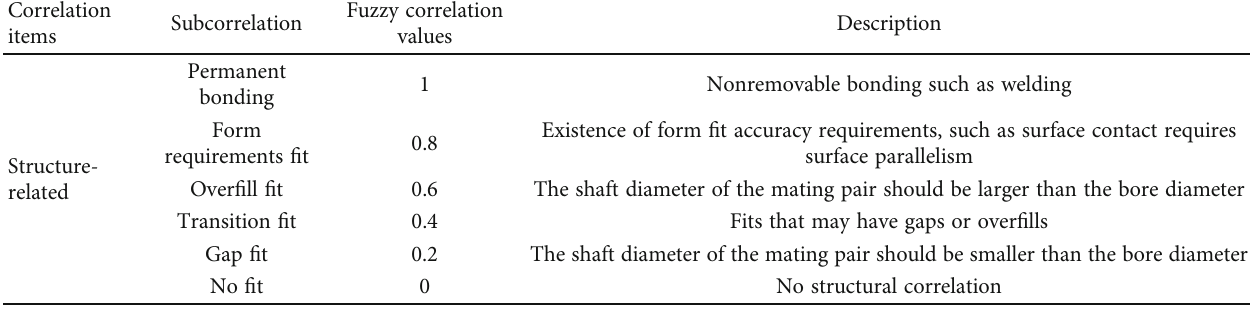
Table 2: Structure correlation.